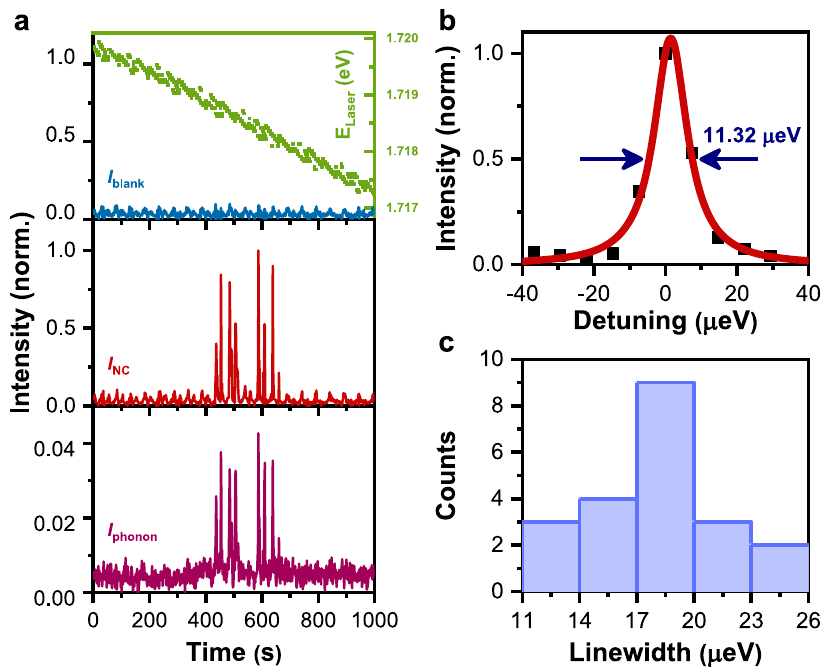
Fig. 2 Resonance fl uorescence from a single CsPbI 3 NC. a (top panel) Time-dependent energy and intensity of the moving laser peak scanned from ~1.720 – 1.717 eV on the blank sample area. (middle panel) The same intensity measurement on the single-NC sample area. (bottom panel) Integrated PL intensity of the two LO phonon modes plotted as a function of the measurement time. b PL intensity of the lower-energy peak plotted as a function of the detuned laser energy and fi tted with a linewidth of ~11.32 µ eV for this single CsPbI 3 NC. c Statistical histogram showing the linewidth distribution of the PL excitation spectra measured for the emission states of 21 single CsPbI 3 NCs.